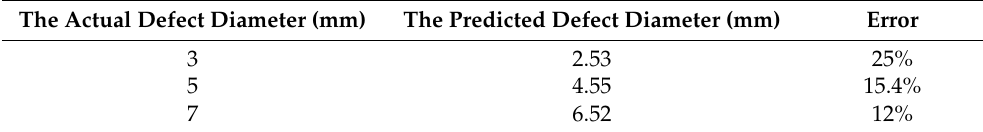
Table 4. The predicted diameter and actual diameter of the prepared interfacial defect in TBCs measured by the method of Guo et al.